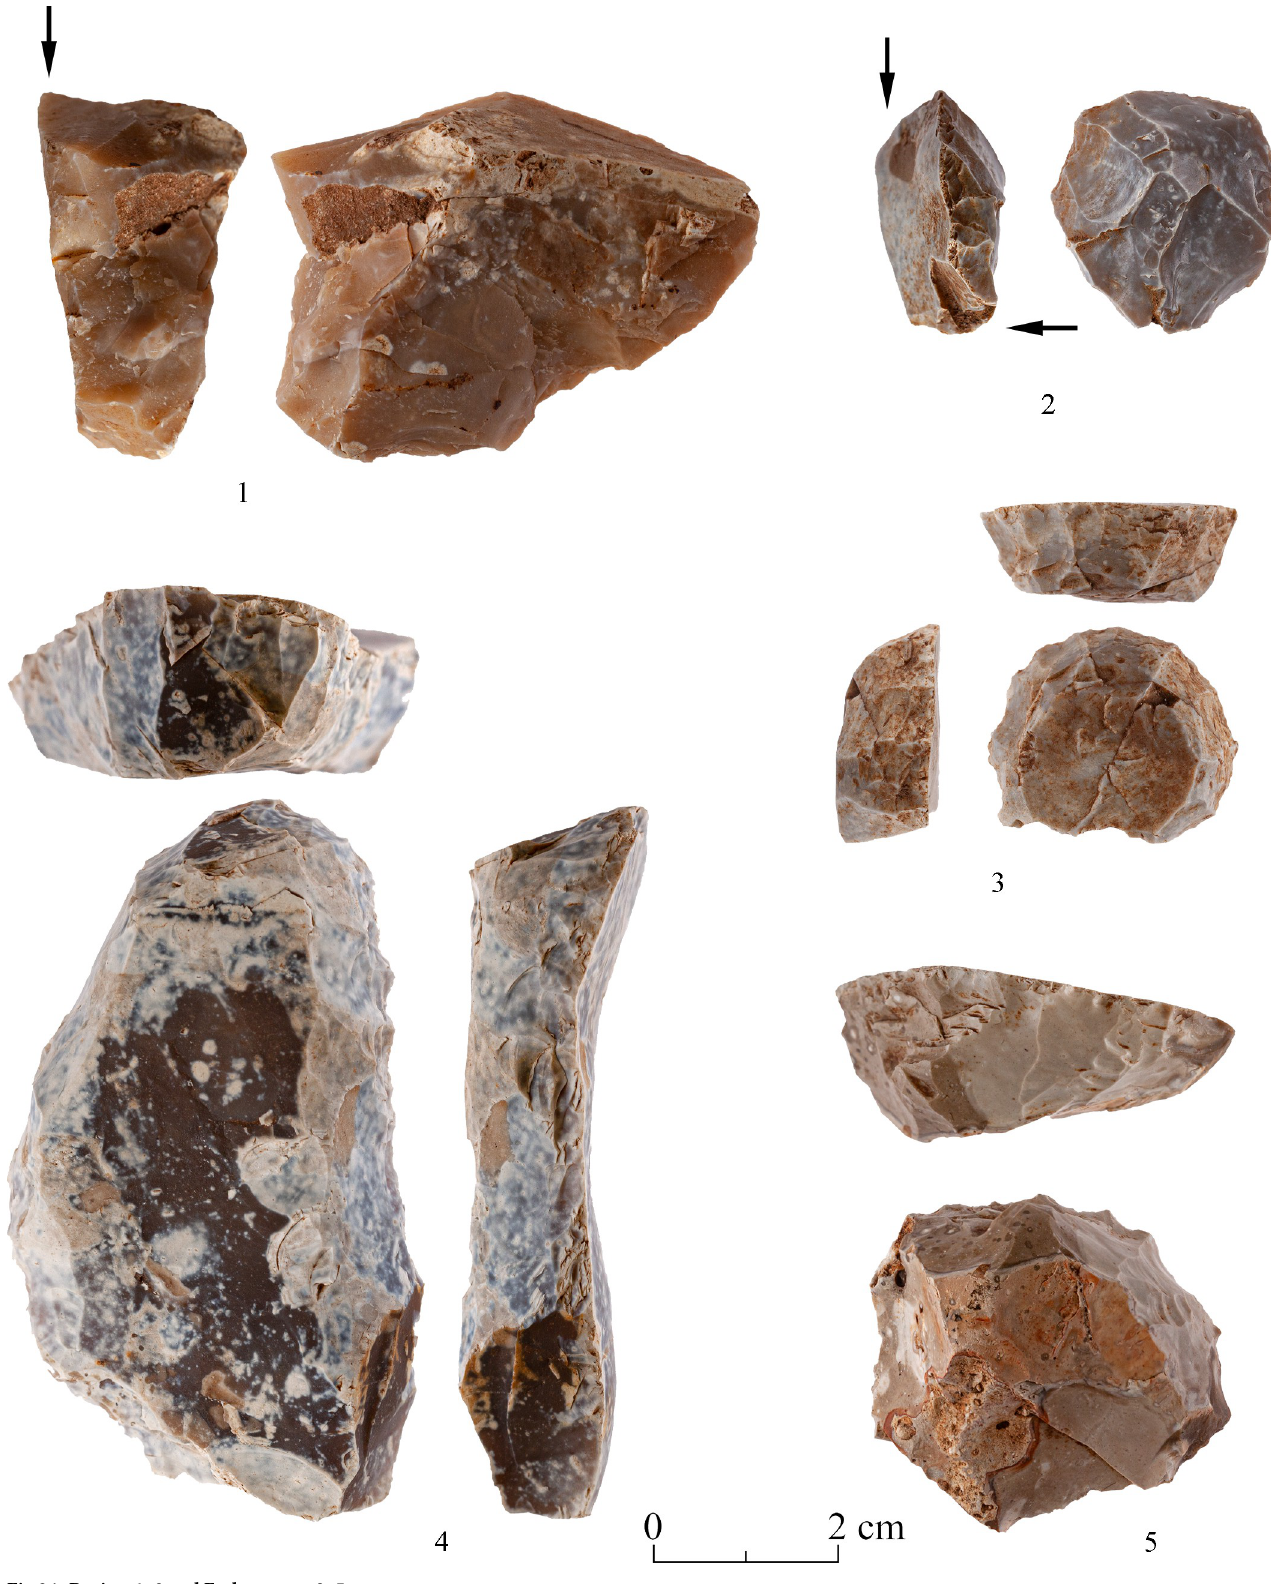
Fig 24. Burins: 1–2 and Endscrapers: